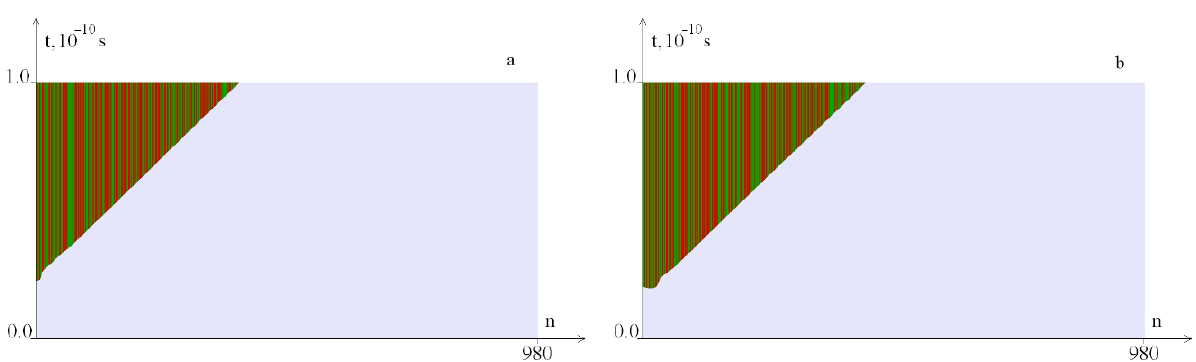
Figure 7. OS regions under the local torque influence on 1–100 pairs of nitrogenous bases with different M 0 values: ( a )—at M 0 = 16.8; ( b )—at M 0 = 16.9; green indicates OS in A–T pairs, red, in G–C pairs.